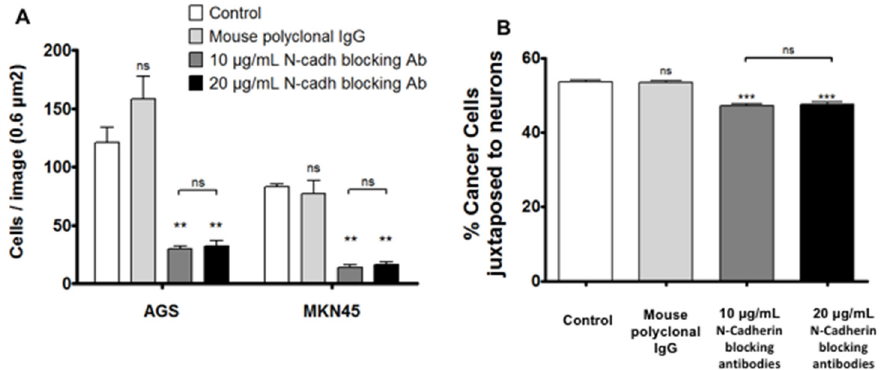
Figure 4. Impact of N-Cadherin on the adhesion of diffuse-type gastric cancer cells to ENS. ( A ) Comparison of the number of cells per image (0.6 mm 2 ) between co-cultures of GC cells with pcgENS pretreated for 1 h with anti-N-Cadherin blocking antibody 10 µg/mL, anti-N-Cadherin blocking antibody 20 µg/mL, polyclonal mouse IgG 10 µg/mL, or media alone ( n = 5 wells per condition; ns = non-significant; ** p < 0.01; Ab = antibody; Mann–Whitney test). A significant decrease in tumor cell adhesion of pcgENS is observed after blocking N-Cadherin. ( B ) Comparison of % of adhered cells between co-cultures of GC cells with pcgENS pretreated for 1 h with 10 µg/mL blocking anti-N-Cadherin antibody, 20 µg/mL blocking anti-N-Cadherin antibody, 10 µg/mL polyclonal mouse IgG or media alone ( n = 10 wells per condition; ns = non-significant; *** p < 0.001; Mann–Whitney test).